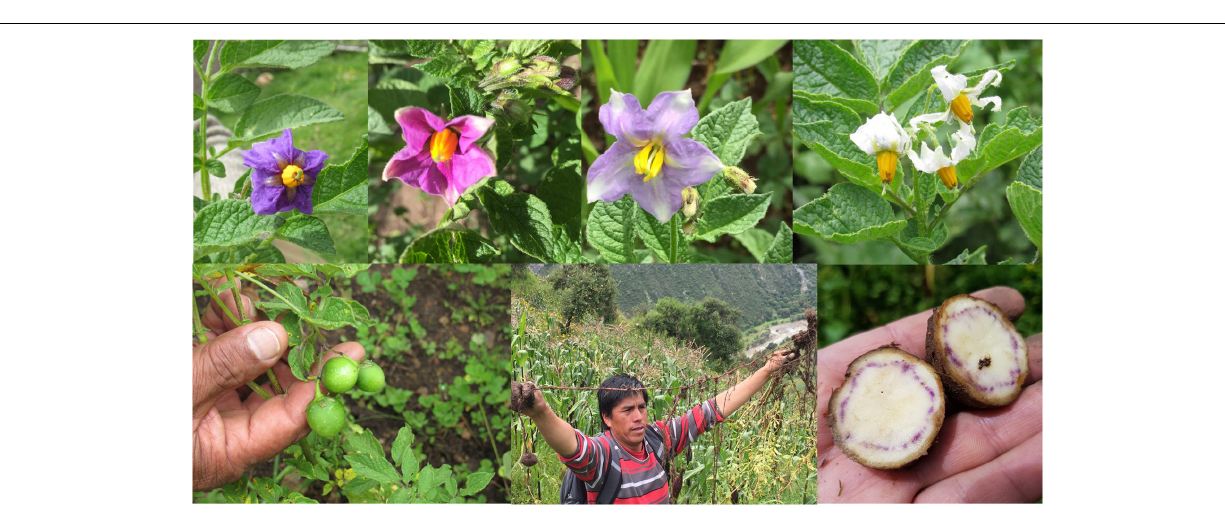
FIGURE 4 | Aspects of the morphology of araq papas . The upper row of images shows aspects of some of the different flower types recorded among the araq papas . The lower row of images shows a panorama of the fruits, the long stolon characterizing these plants (the person showing the stolon is Jorge Segovia, co-author of this study), and a transversal section of the tuber showing aspects of the thick skin and inner tissue, which is highly variable. The person appearing in the photograph of Figure 4 is Jorge Segovia, co-author of this manuscript, who agreed with both text and images contained in